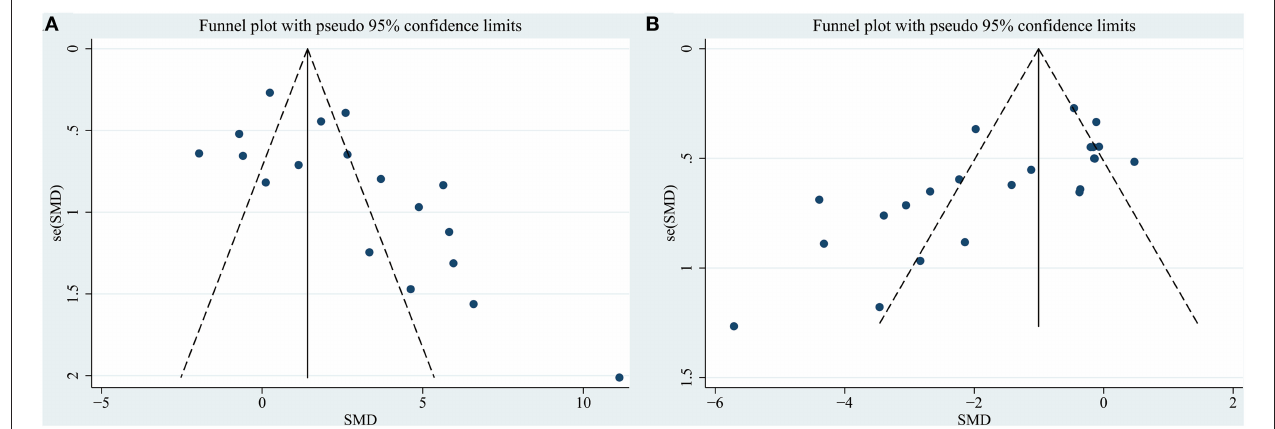
FIGURE 3 | Funnel plot for (A) densitometry of TH + staining in the substantia nigra pars compacta, (B) rotational behavior. Each dot in the figure represents a study, with the y-axis signifying study quality and the x-axis showing the study results. SMD, standardized mean difference.